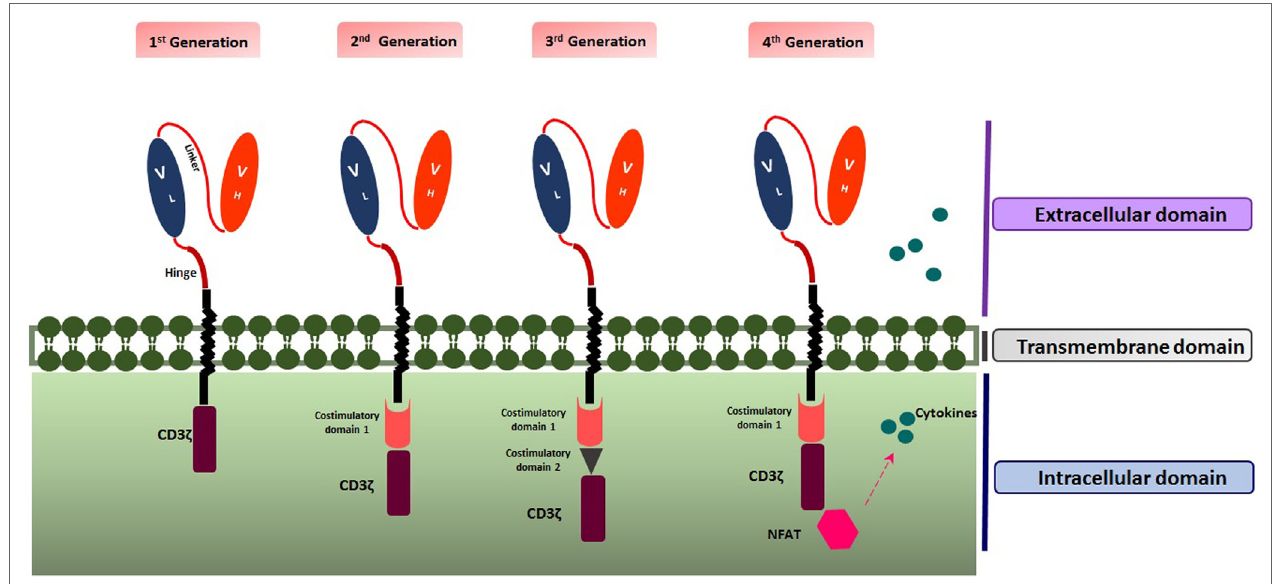
FiGURe 1 | Structure of the four generations of chimeric antigen receptors. Created by Esmaeilzadeh et al.